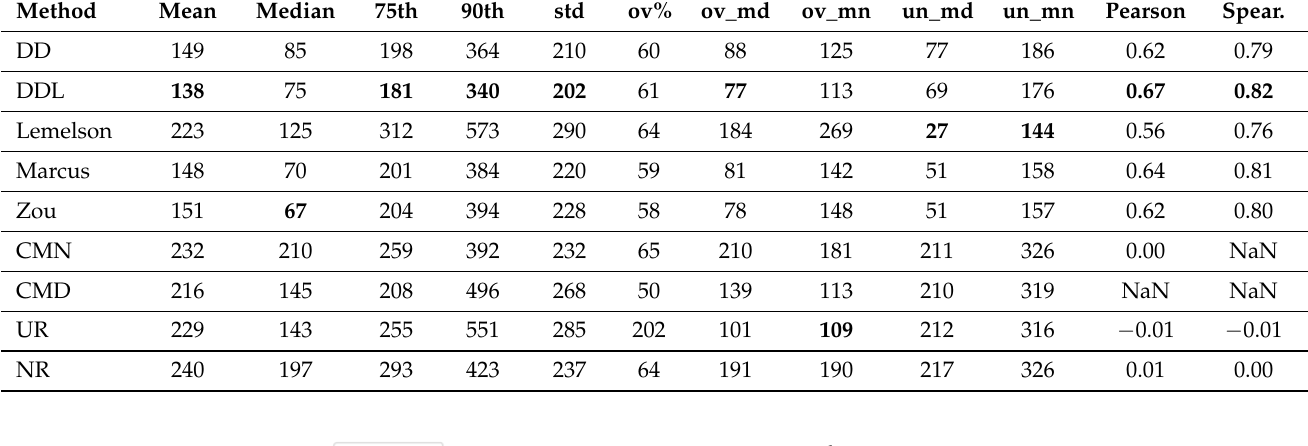
Table 5. The performance of all studied methods and baselines, based on various evaluation metrics, on the validation set of the LoRaWAN dataset. The first five columns report statistics ( mean, median, 75th percentile, 90th percentile, and standard deviation ) of the absolute DAE error. The next column “ ov% ” describes the percentage of DAE overestimation (percentage of estimates where the actual location is “ inside the DAE circle ”). The mean and median DAE error of the overestimated estimates are reported under “ ov_ mn ” and “ ov_ md ”, respectively. The same statistics for the underestimation case are provided under “ un_ mn ” and “ un_ md ”, respectively. Lastly, Pearson’s correlation coefficient and Spearman’s (rank) correlation coefficient between the DAE values and the actual positioning errors are reported in the last two columns. The best performance for each metric is highlighted in bold.